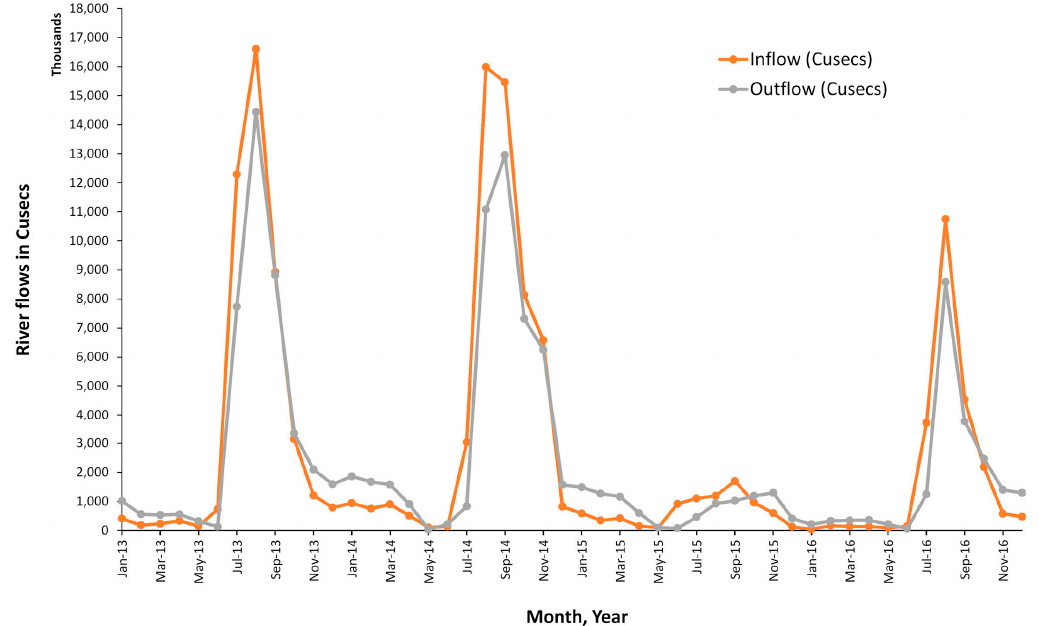
Figure 10. Inflows into and outflows from the Krishna Basin between 2013 and 2016 [47].